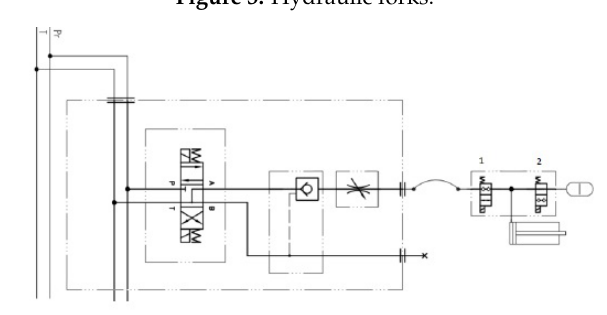
Figure 3. Hydraulic forks.